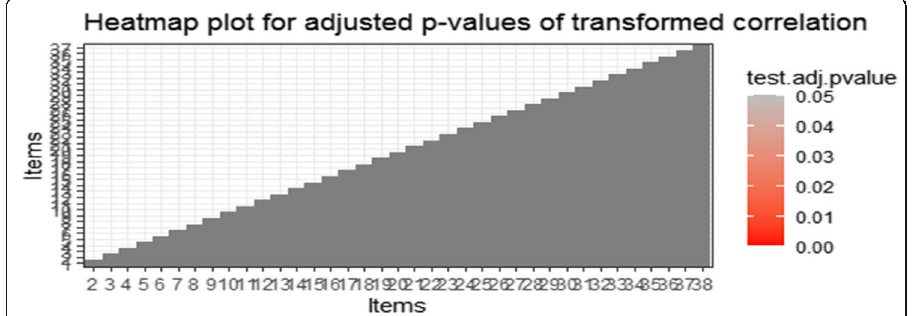
Fig. 2 Heatmap plot for the final Q-matrix